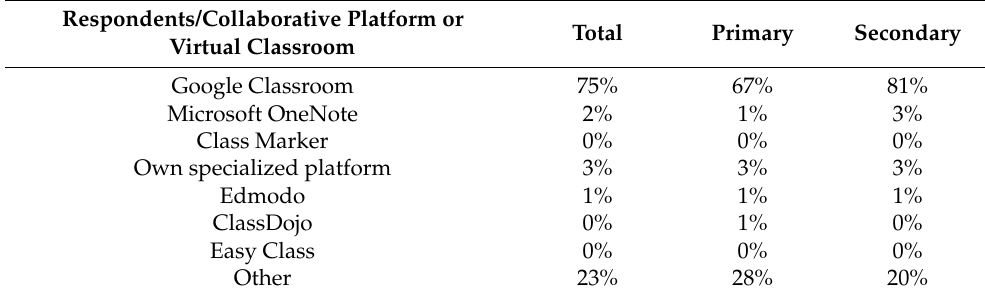
Table 12. Collaborative platform or virtual classroom used for student management, transmission of materials, homework, or progress evaluation during the COVID 19 pandemic (question 7).